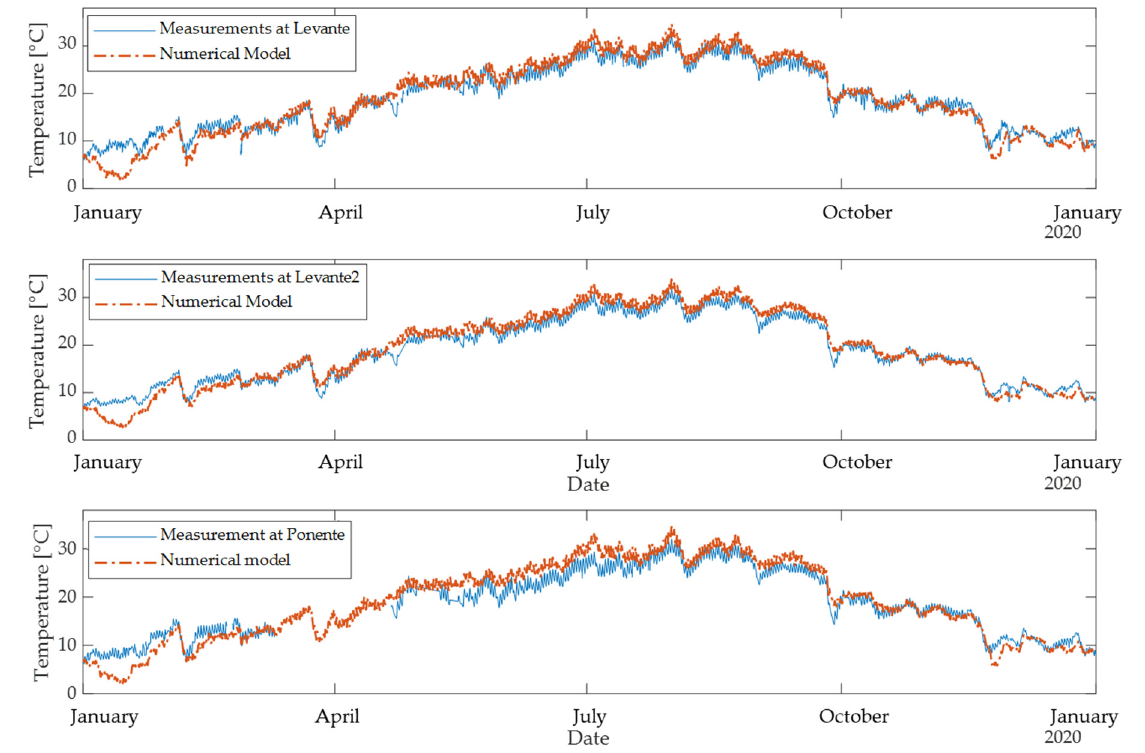
Figure 5. Comparison of time series of hourly temperature measured at the different monitoring station and simulated by the numerical model. From the top to the bottom, stations of Levante, Levante2, and Ponente.